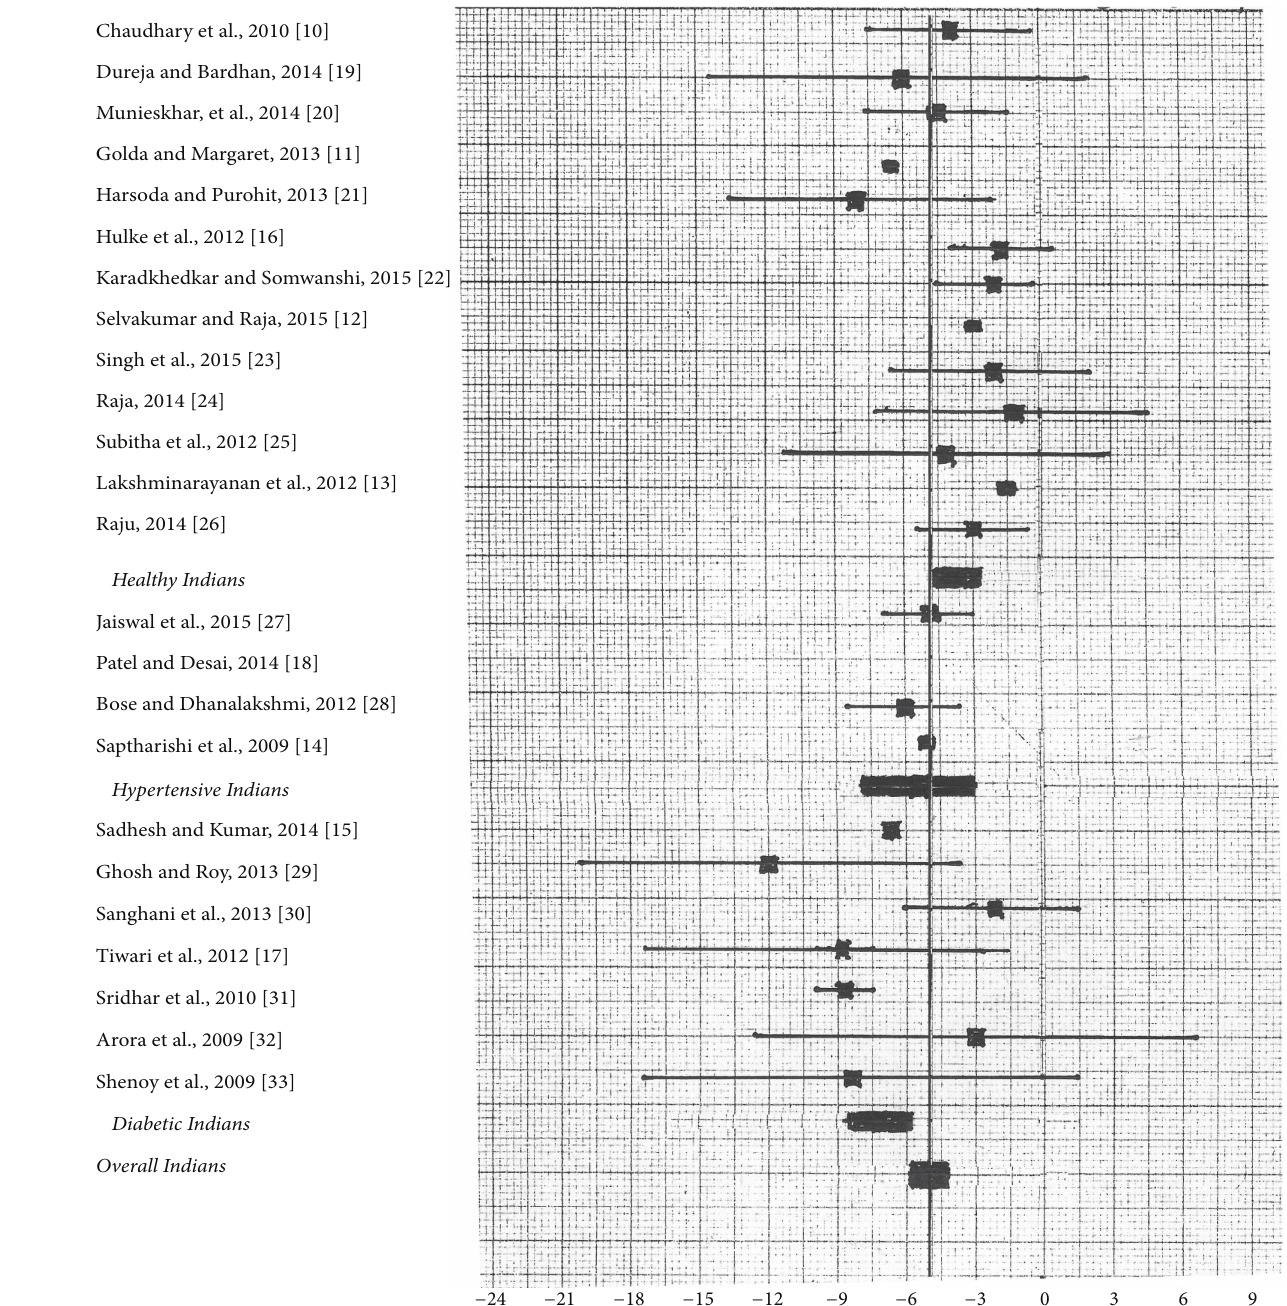
Figure 1: Summary of aerobic training on SBP (mean difference with 95% CI) in Indians. Bold vertical line is meta-analysis mean ( 𝑛 = 23 ).